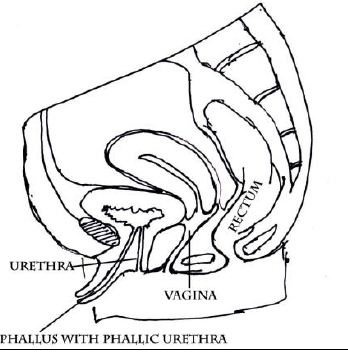
Figure 2: Absent labia minora and normal vaginal and anal openings